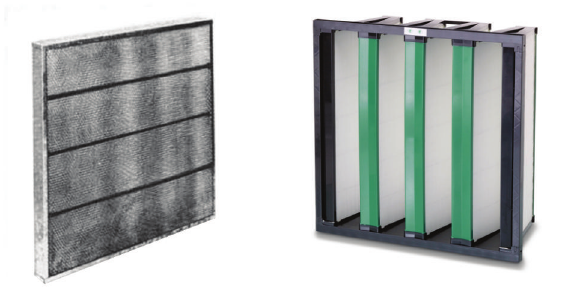
Figure 7: Rectangular high-e ffi ciency filters [35, 36].